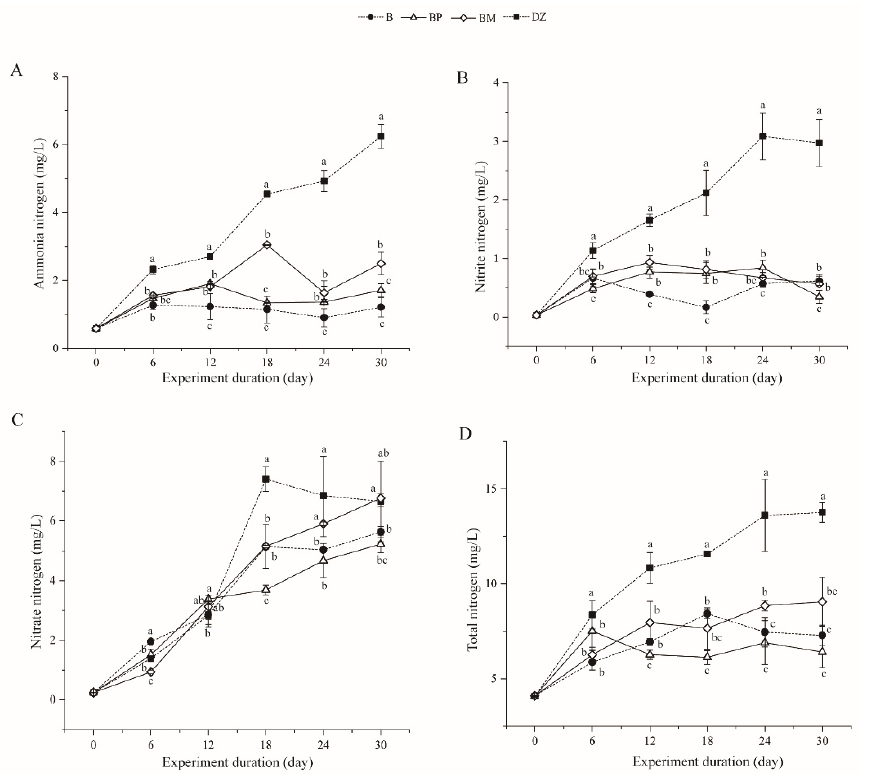
Figure 1. Changes of Ammonia nitrogen ( A ), Nitrite nitrogen ( B ), Nitrate nitrogen ( C ), and Total nitrogen ( D ) in the water of different groups. Note: group B, a single B. pumilus BP-171, was added; the group BP, B. pumilus BP-171, and PHBV were added; the group BM, B. pumilus BP-171, and molasses were added; the group DZ, the control without any probiotics and carbon sources addition. Values with different superscripts on the same day are significantly different among treatments in each figure ( p < 0.05).